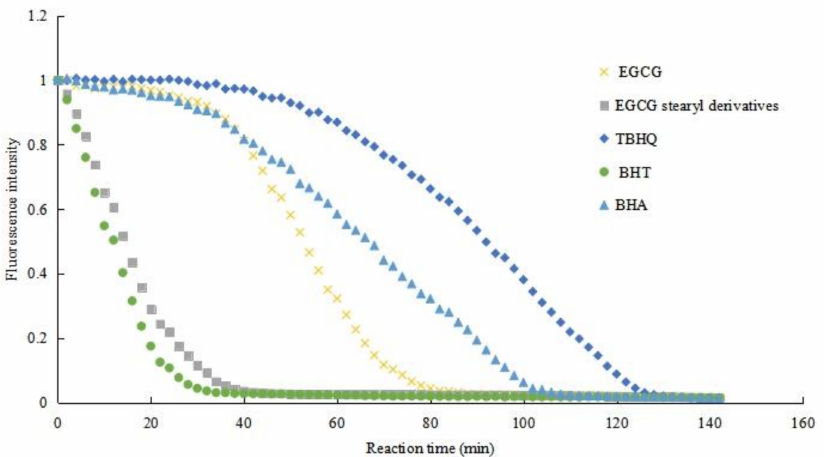
Figure 6. Oxygen radical absorbance capacity of EGCG, EGCG stearyl derivatives, and synthetic antioxidants. Hydrophobicity is the main factor affecting the activity of phenolic compounds